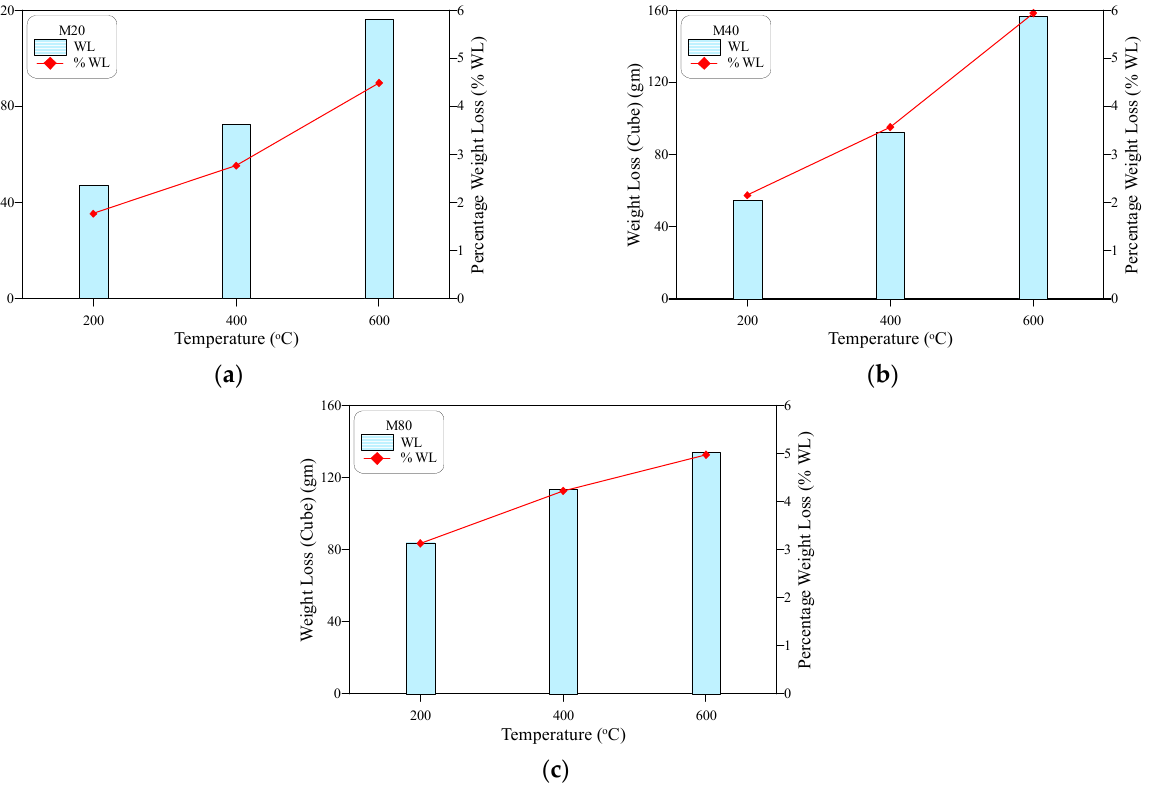
Figure 7. Weight loss of the heated cubes: ( a ) M20, ( b ) M40, ( c ) M80.